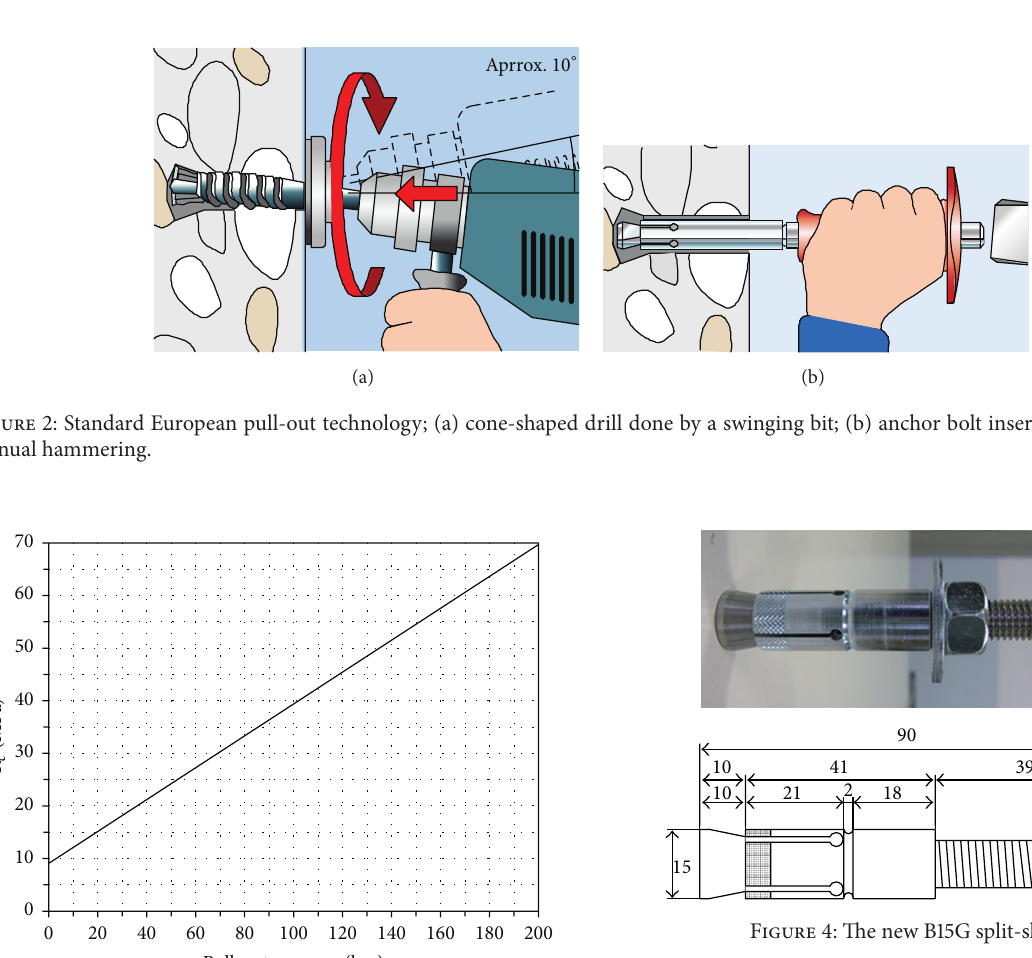
Figure 1: Failure mechanism of the pull-out test [1].